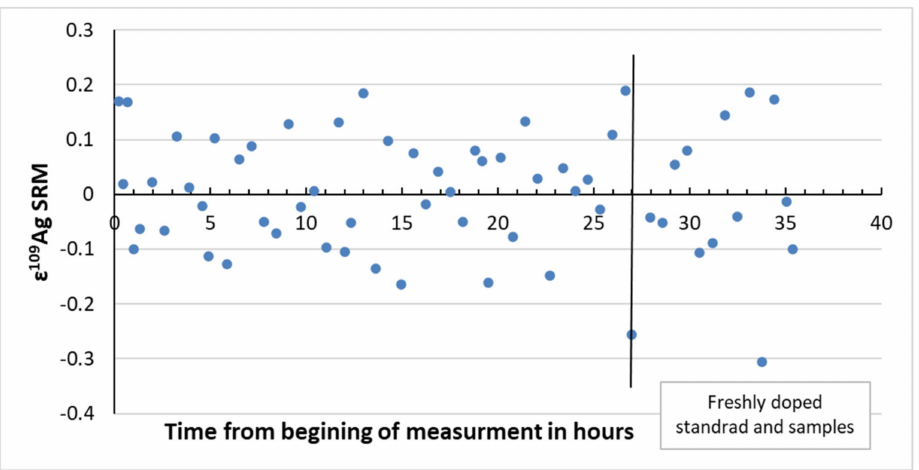
Figure 3. Results of ε 109 Ag of bracketing standard versus time from beginning of